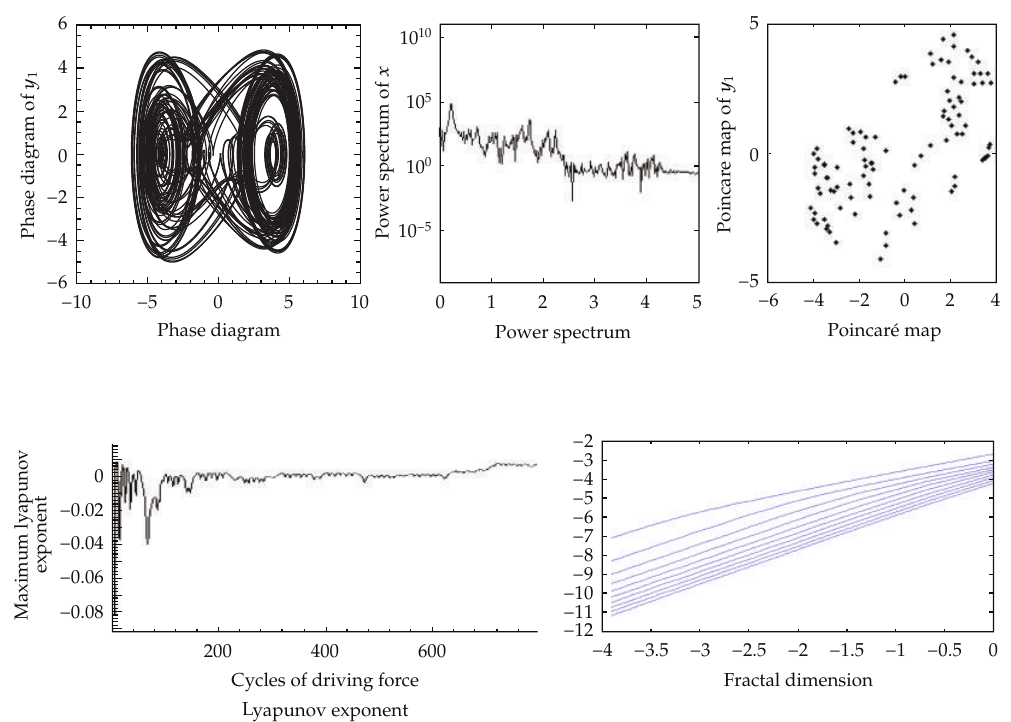
Figure 10: Simulation results obtained for gear-bearing system with s (cid:9) 5 . 0 for y 1 (cid:6) l ∗ (cid:9) 0 . 3 (cid:7)